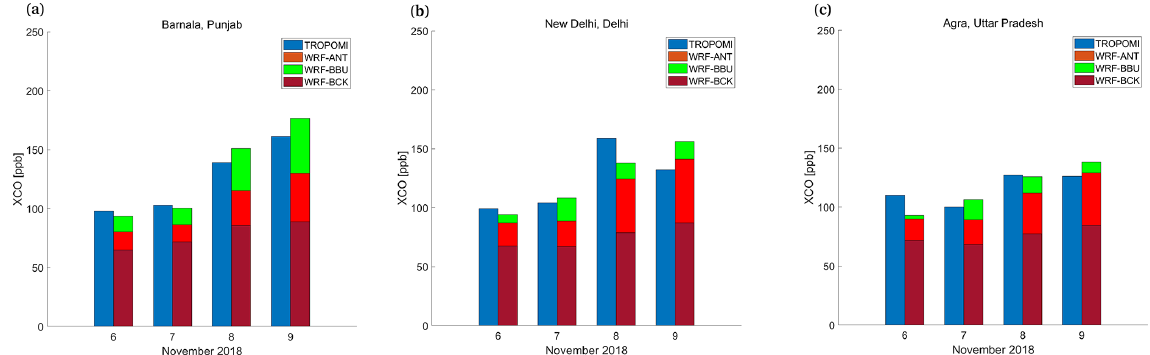
Figure 6. Carbon monoxide (CO) total column mixing ratios over (a) Barnala, (b) New Delhi, and (c) Agra for individual days from 6–9 November